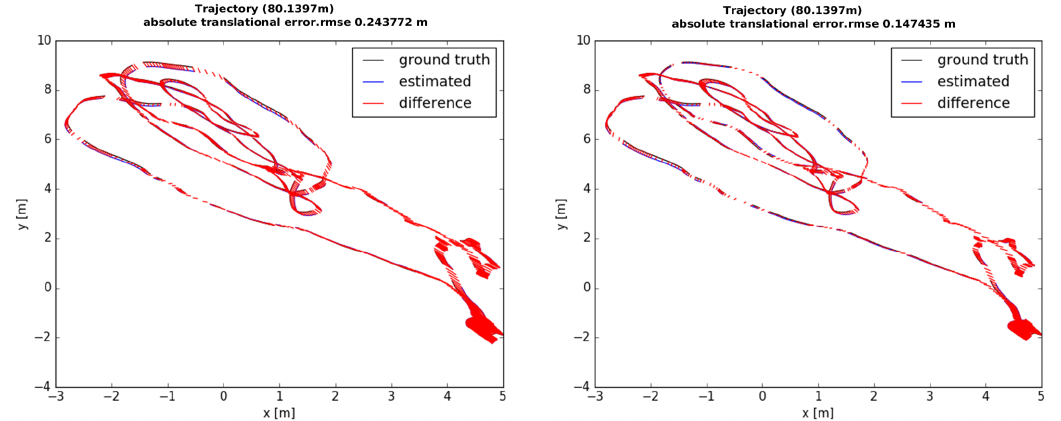
Figure 5. Illustration of the proposed visual inertial local bundle adjustment. All keyframe poses (cid:104) w θ 0 , w θ 1 , . . . , w θ n (cid:105) contain the visual terms with landmarks and the IMU pre-integration factors with d d d a common local scale parameter. The current frame n (which may not be a keyframe) is included in the local window with the accumulated IMU pre-integration.